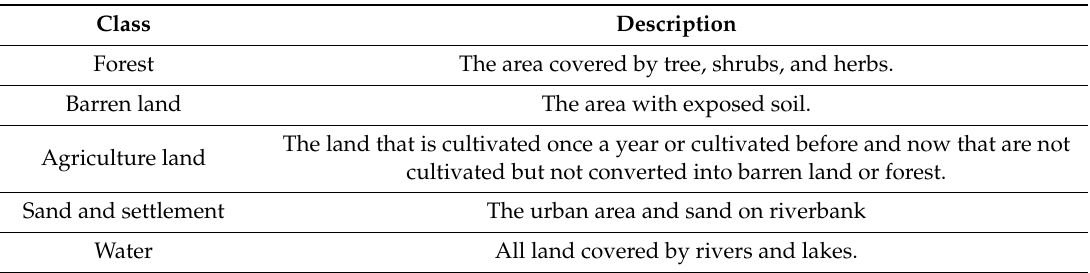
Table 2. Land use land cover